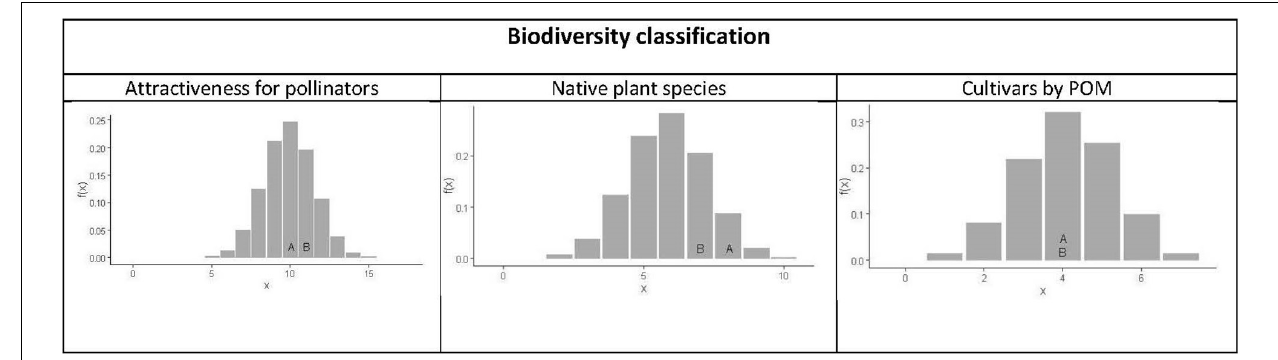
FIGURE 6 | The probability function for the number of attractive plant species for pollinators (left), native plant species (central) and cultivars with conservation value of a random selection of the 43 species possible to use in the design. The letters A and B in the figures correspond to the number of species in the designs based on light-dark (A) and complementary (B) colour